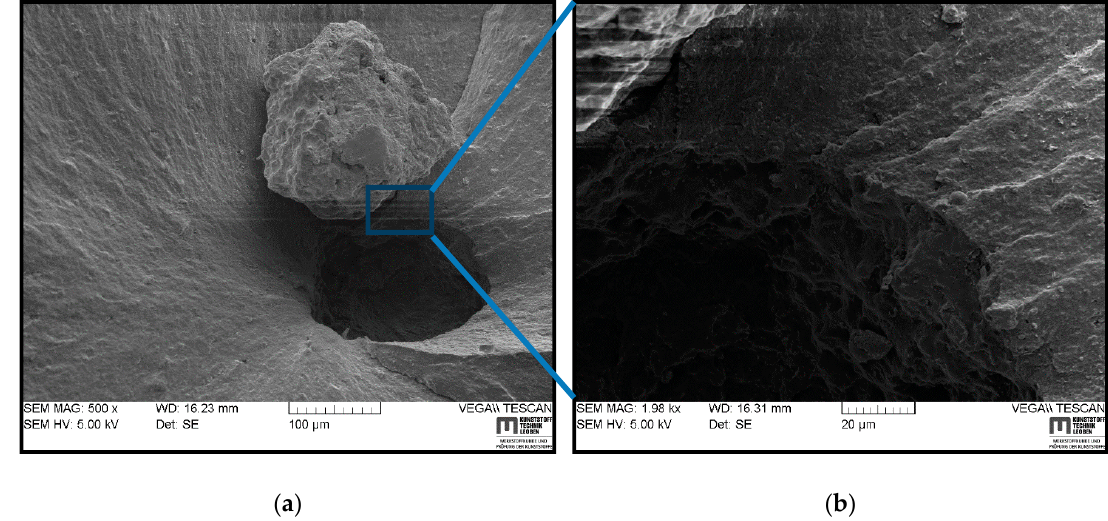
Figure 8. SEM images of a fracture surface of HNBR3 in different magnifications: ( a ) fracture initiation from a rigid body; ( b ) magnified view of fracture initiation and propagation.